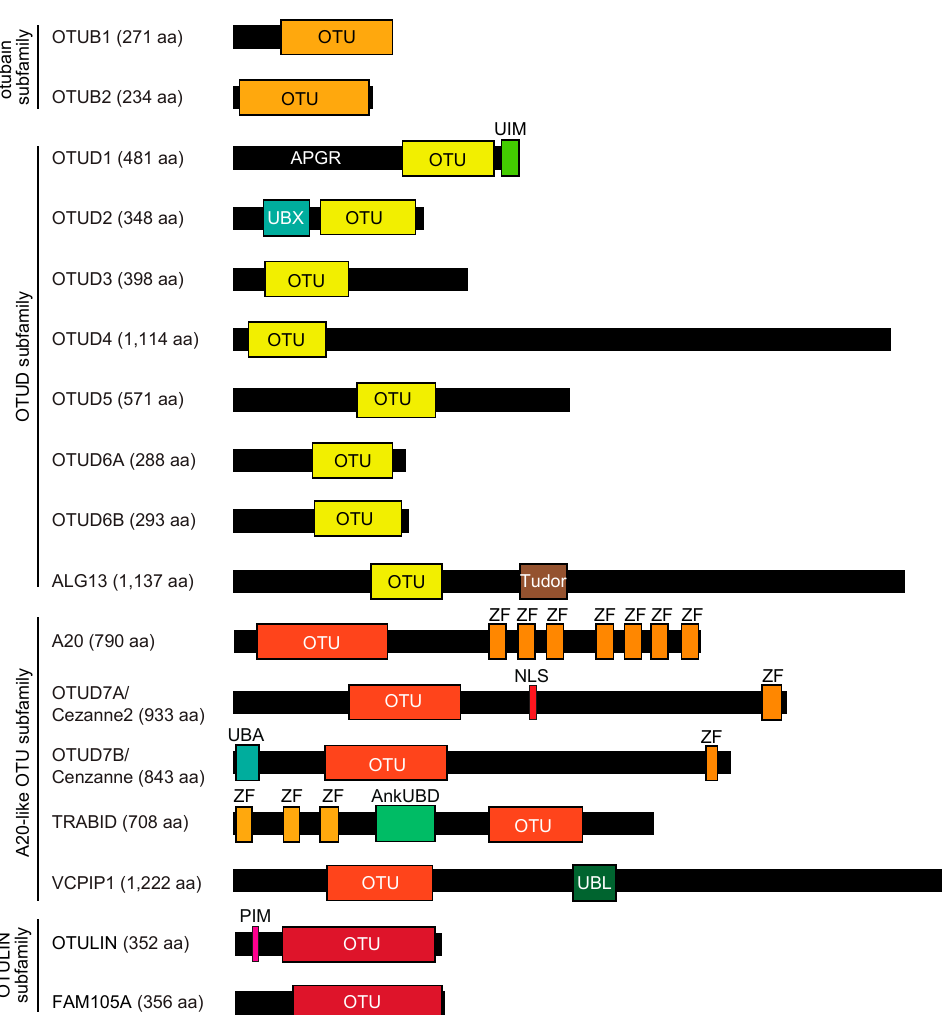
Figure 1. Domain structures of OTU family deubiquitinating enzymes (DUBs). The seventeen human OTU family DUBs are classified into four subfamilies, and the total numbers of amino acid residues and domain organizations are shown. OTU, ovarian tumor protease; APGR, Ala-, Pro-, and Gly-rich region; UIM, ubiquitin-interacting motif; UBX, ubiquitin regulatory X; Tudor, Tudor domain; ZF, zinc finger; NLS, nuclear localization signal; UBA, ubiquitin-associated; AnkUBD, ankyrin repeat ubiquitin-binding domain; UBL, ubiquitin-like; PIM, PUB domain-interacting motif.